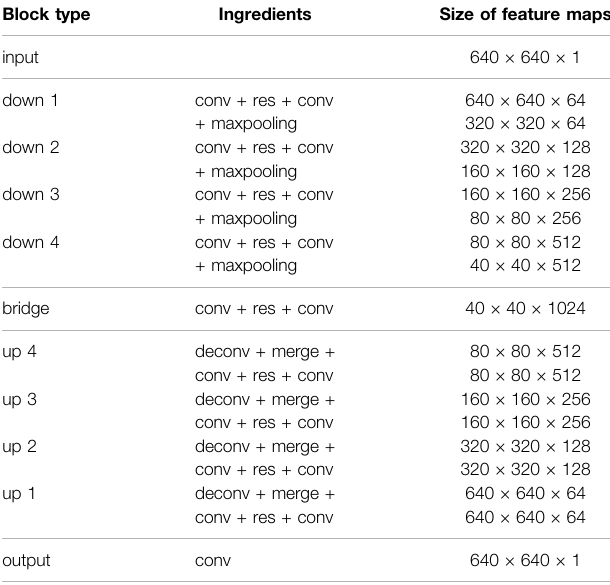
TABLE 1 | Architecture of the proposed network.